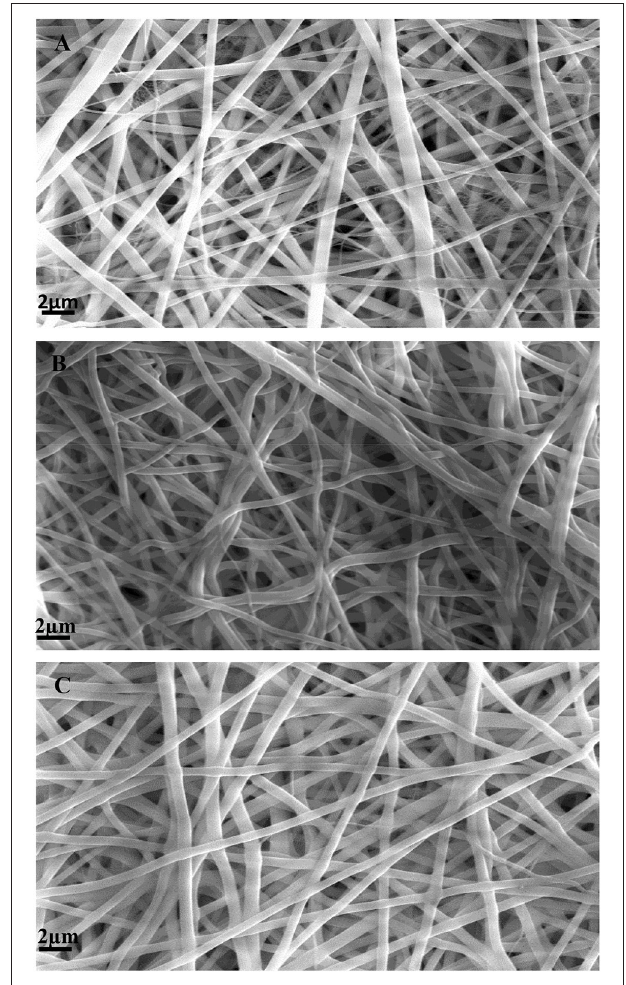
FIGURE 2 | SEM micrographs of GTA crosslinked nanofiber mats: (A) SF, (B) SF/gelatin at the blend ratio of 90/10, and (C) SF/gelatin at the blend ratio of